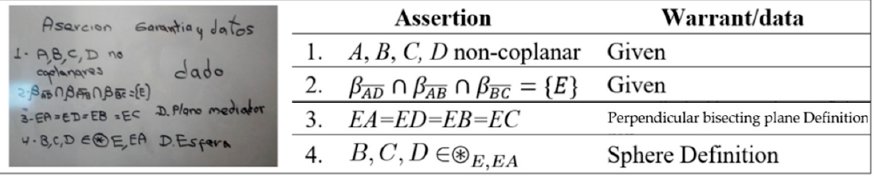
Figure 11. Conjecture 3 ′ s proof transcription.